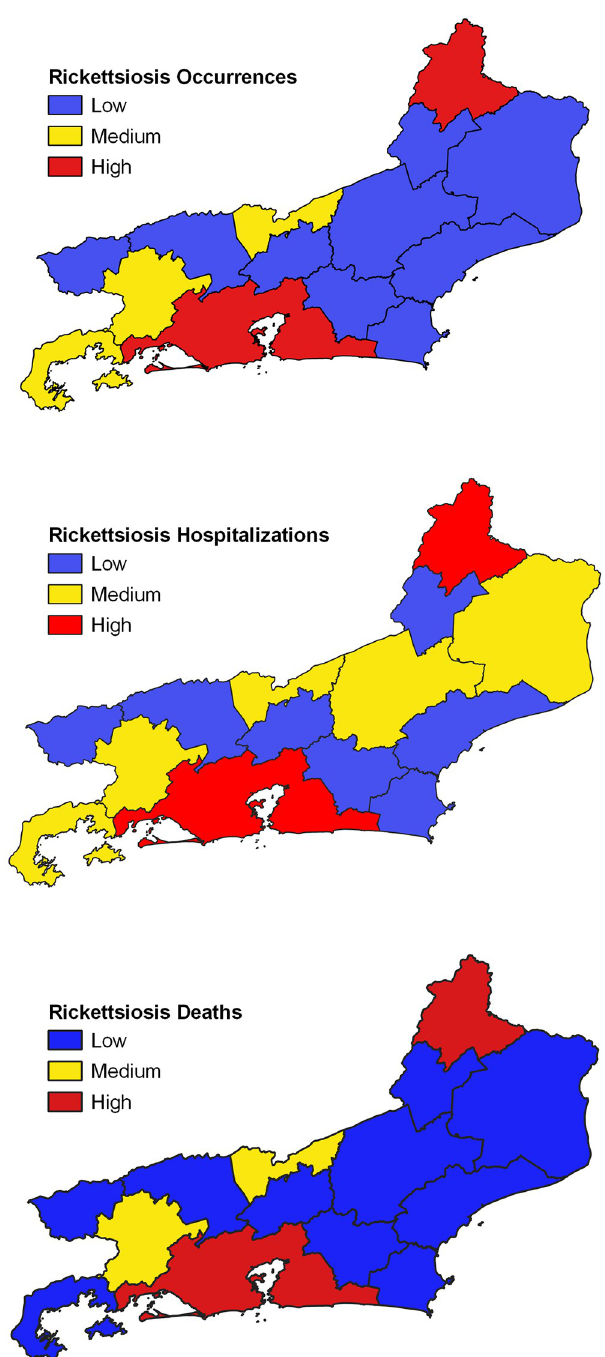
Fig 7. Spotted fever occurrences, hospitalizations and deaths between 2007 and 2016 in Rio de Janeiro state, Brazil. Occurrences Cases; Hospitalizations; Deaths and respective Three-colour scale: blue colours—low; yellow colours—medium; red